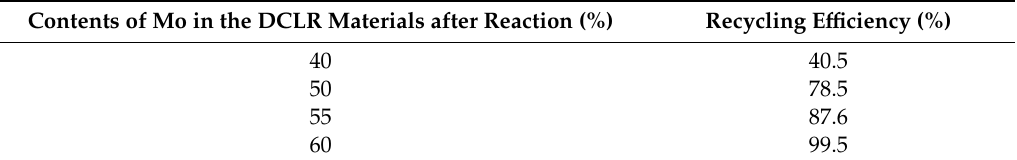
Table 3. Effect of the content of Mo in the residue DCLR after extraction on recycling efficiency. Table 3. E ff ect of the content of Mo in the residue DCLR after extraction on recycling e ffi ciency. Contents of Mo in the DCLR Materials after Reaction (%)